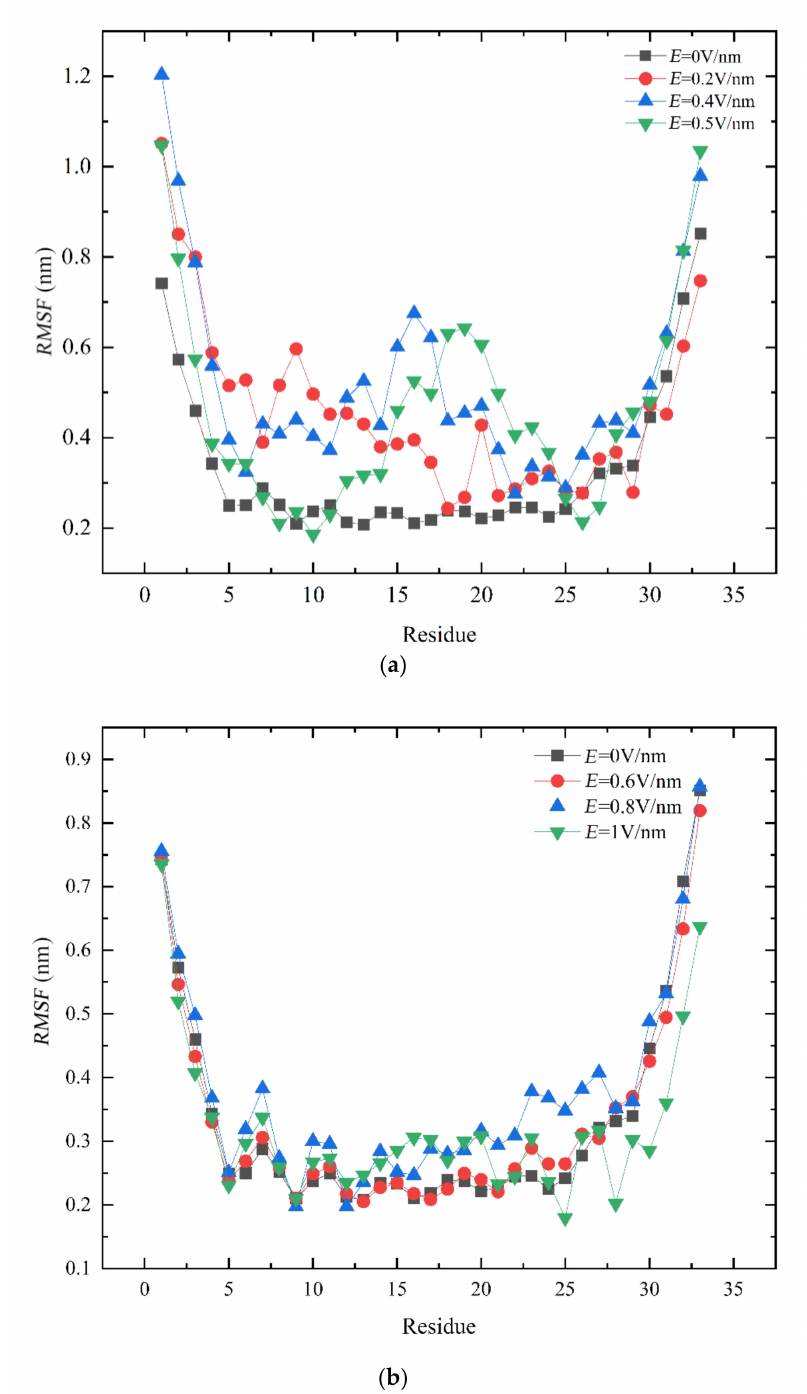
Figure 2. (Color online) Root mean square fluctuations ( RMSF ) of α -atoms of the protein GLP-2 in the 100 ns. ( a ), E = 0 V/nm (black line), E = 0.2 V/nm (red line), E = 0.4 V/nm (blue line), E = 0.5 V/nm (green line). ( b ), E = 0 V/nm (black line), E = 0.6 V/nm (red line), E = 0.8 V/nm (blue line), E = 1 V/nm (green